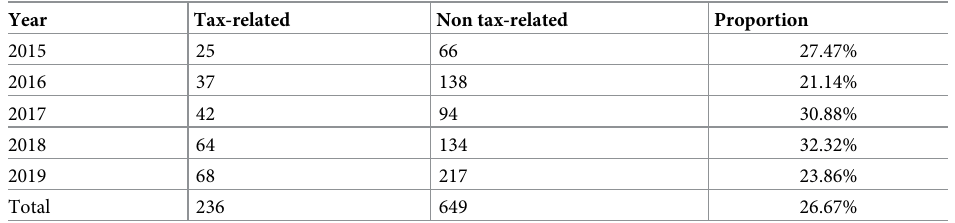
Table 1. Annual sample distribution of comment